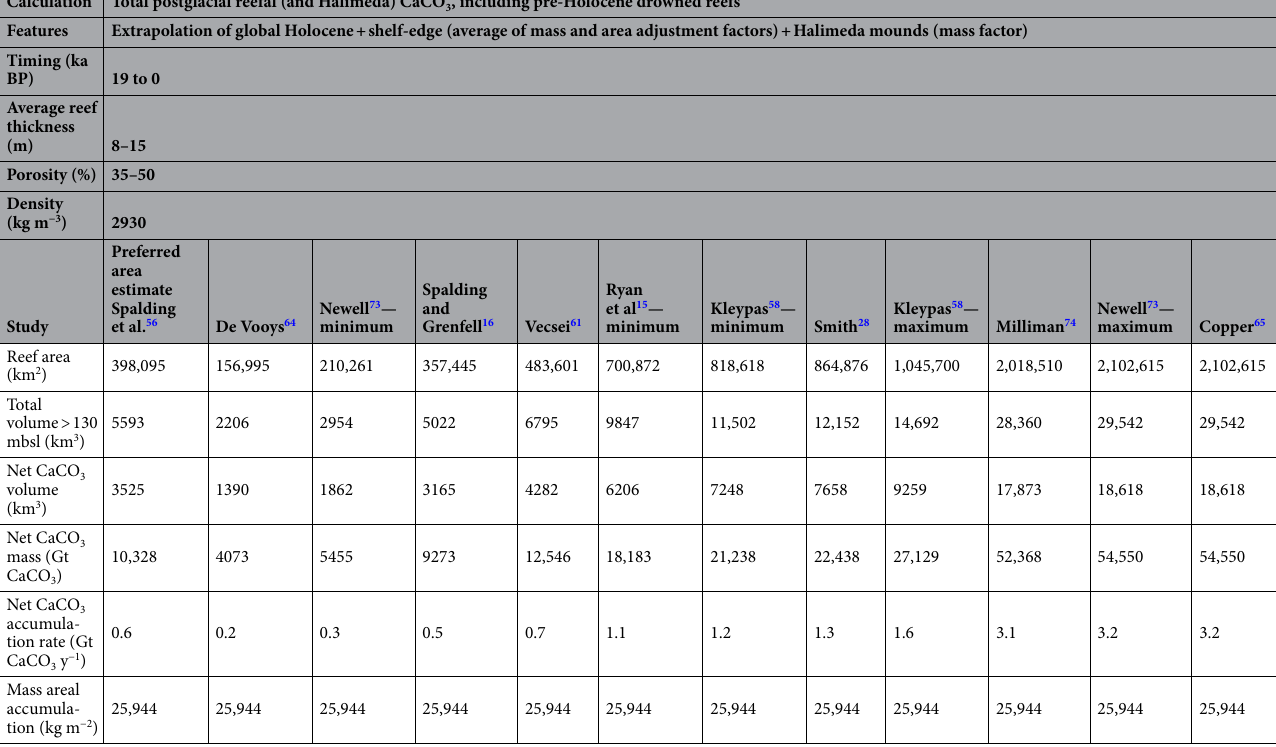
Table 4. Extrapolations of global CaCO 3 deposits applying the parameters of this study (Table 3) but using the broad range of past global reef area estimates shown in Table 5.